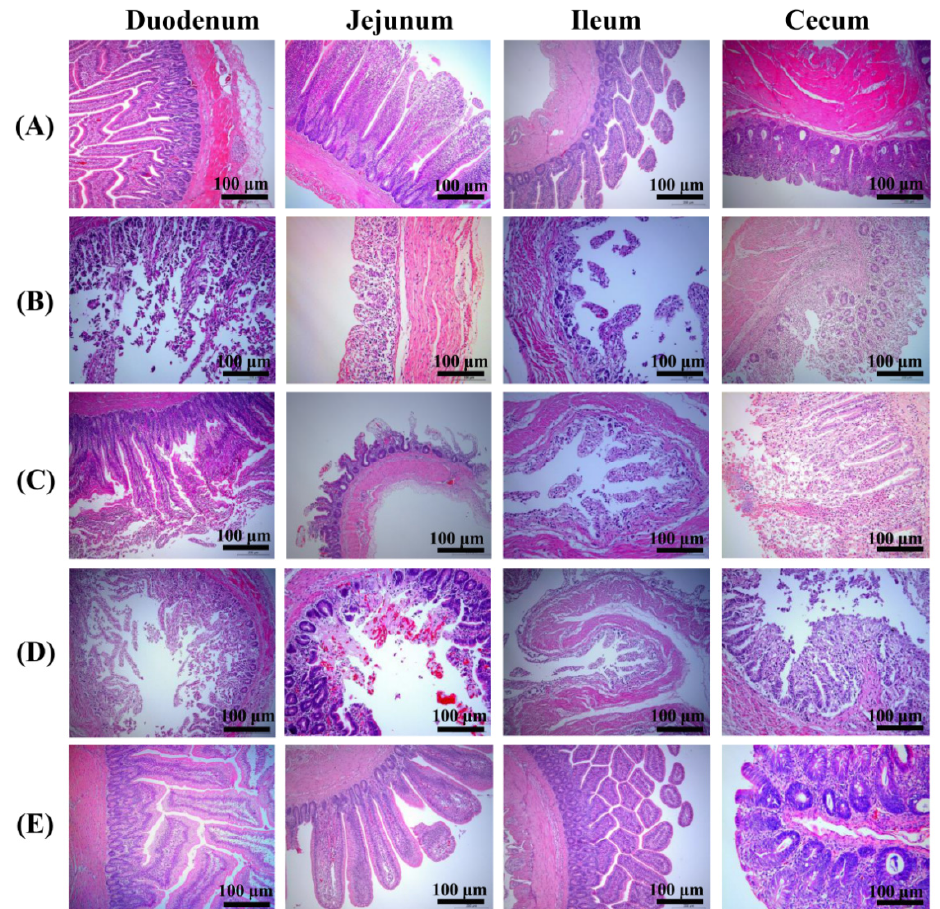
Figure 8. Histopathological changes in immunized chickens after a challenge with the α - β 2- ε - β 1 fusion protein. Intestinal sections of ( A ) control group without challenge, ( B ) PBS group post-challenge, ( C ) L. crispatus N-11 group post-challenge, ( D ) pPG-T7g10-PPT/ L. crispatus N-11 group post-challenge, and ( E ) pPG-E- α - β 2- ε - β 1/ L. crispatus N-11 group post-challenge.